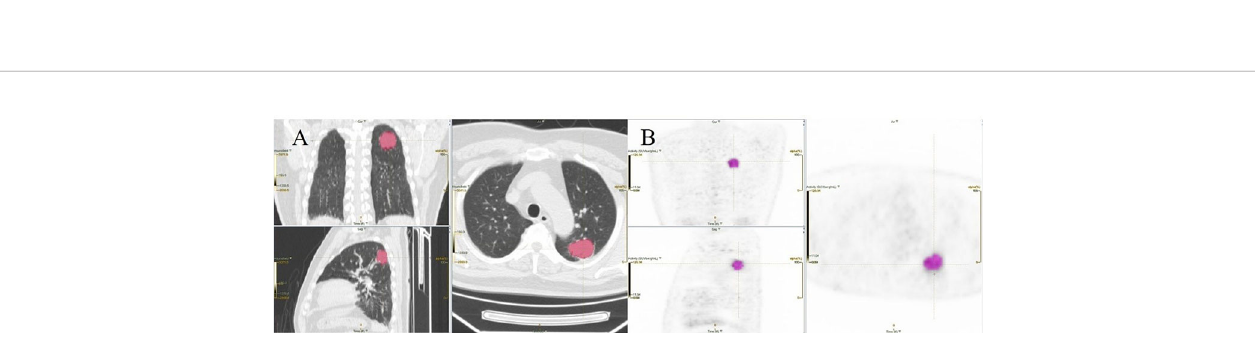
FIGURE 6 | An example of segmentation coronary image, sagittal image, and transaxial images of CT (A) and PET (B) showing an example of VOI for measuring imaging features of